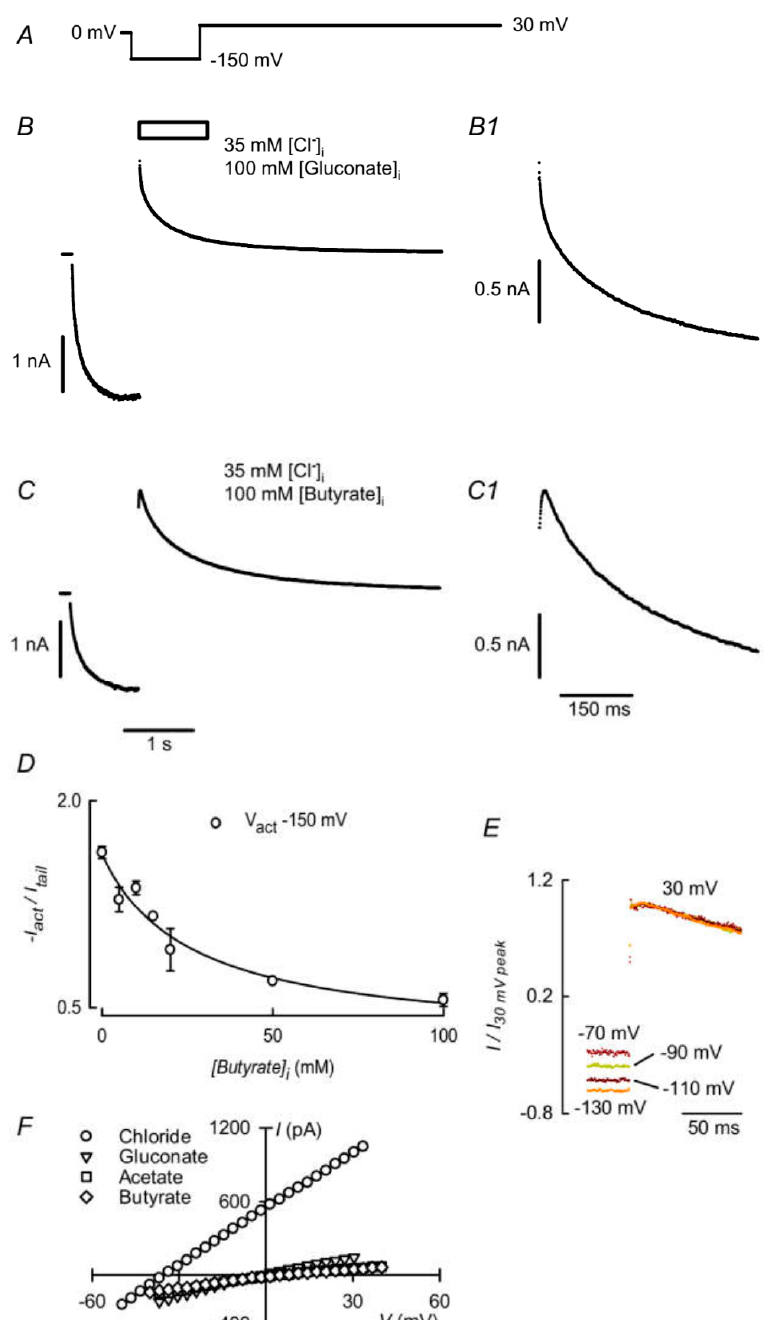
Figure 2. Inhibition of ClC-2 by intracellular butyrate is relieved at positive potentials. ( B ): current mediated by ClC-2 elicited by the voltage protocol shown in ( A ). The intracellular solution contained 35 mM Cl − and 100 mM gluconate. The bath solution contained 146 mM Cl − . ( B1 ): a magnified view of the time course interval indicated by the box above the trace in B is shown. ( C ) and ( C1 ): as ( B ) and ( B1 ) but with 100 mM butyrate replacing gluconate in the intracellular solution. ( D ). Ratio of the absolute value of the current elicited by a − 150 mV activating pulses to those of the respective tail currents at various intracellular butyrate concentrations. Means ± SEM, n = 2–9. ( E ): traces of normalised tail currents in the presence of 100 mM butyrate after activation pulses ranging from − 70 to − 130 mV. ( F ): E ff ect of extracellular anion replacement on ClC-2 current vs. voltage curves. Stretches encompassing the reversal potential are shown for bath 146 mM Cl − solution and after replacement of all but 16 mM Cl − by gluconate, acetate or butyrate. The curves were obtained at the end 1.5 s, − 130 mV activating pulse by means of a linear voltage ramp taking the potential to 30 mV in 25 ms.